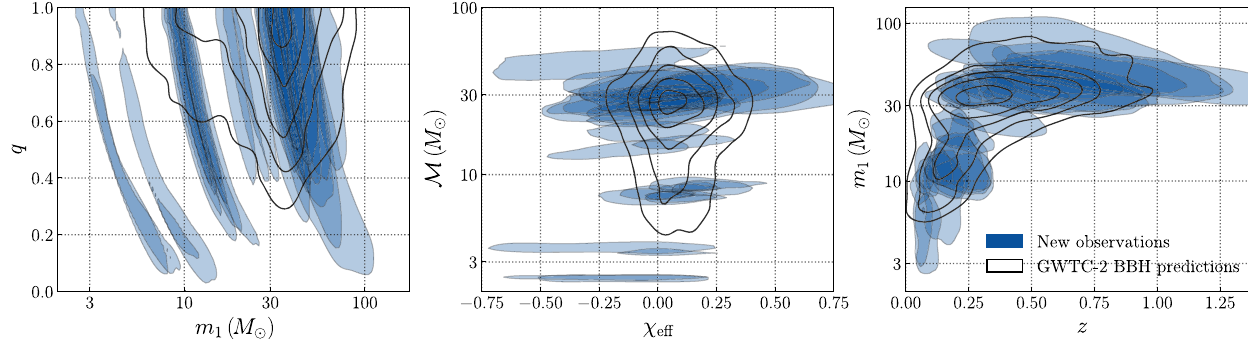
FIG. 1. New observations since GWTC-2. The measured properties of new CBC candidates announced since GWTC-2 with FAR < yr − 1 and reported parameters (blue shaded regions) compared to the expected population of detected BBHs (black contours) as inferred from past analysis of GWTC-2 with the same FAR threshold [114] and the fiducial binary parameter priors described in the text. The left-hand plot shows the inferred primary mass m 1 and mass ratio q , the center plot shows the effective spin χ the right plot shows redshift z and primary mass. The least-massive sources in this sample include NSBH events GW200105 and